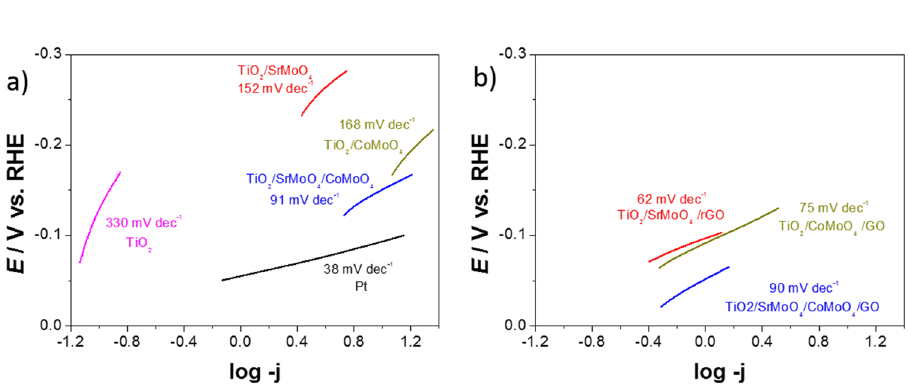
Table 1. The HER parameters, Tafel slopes and estimated electrochemically active surface area for the obtained catalysts.